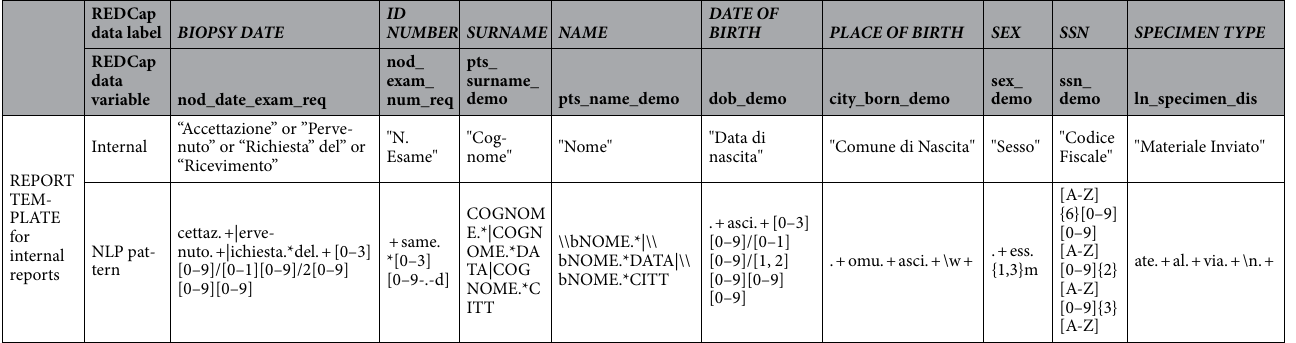
Table S3. Concerning function_read.py , we identified the set of pathological description patterns according to the following four scenarios: